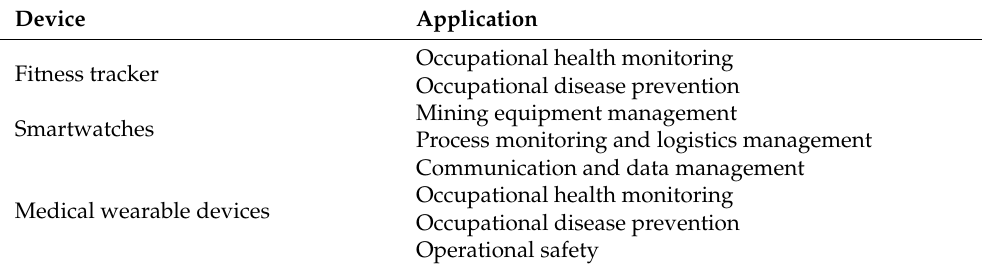
Table 3. Wrist-wearable devices and their relative application capacities [31].